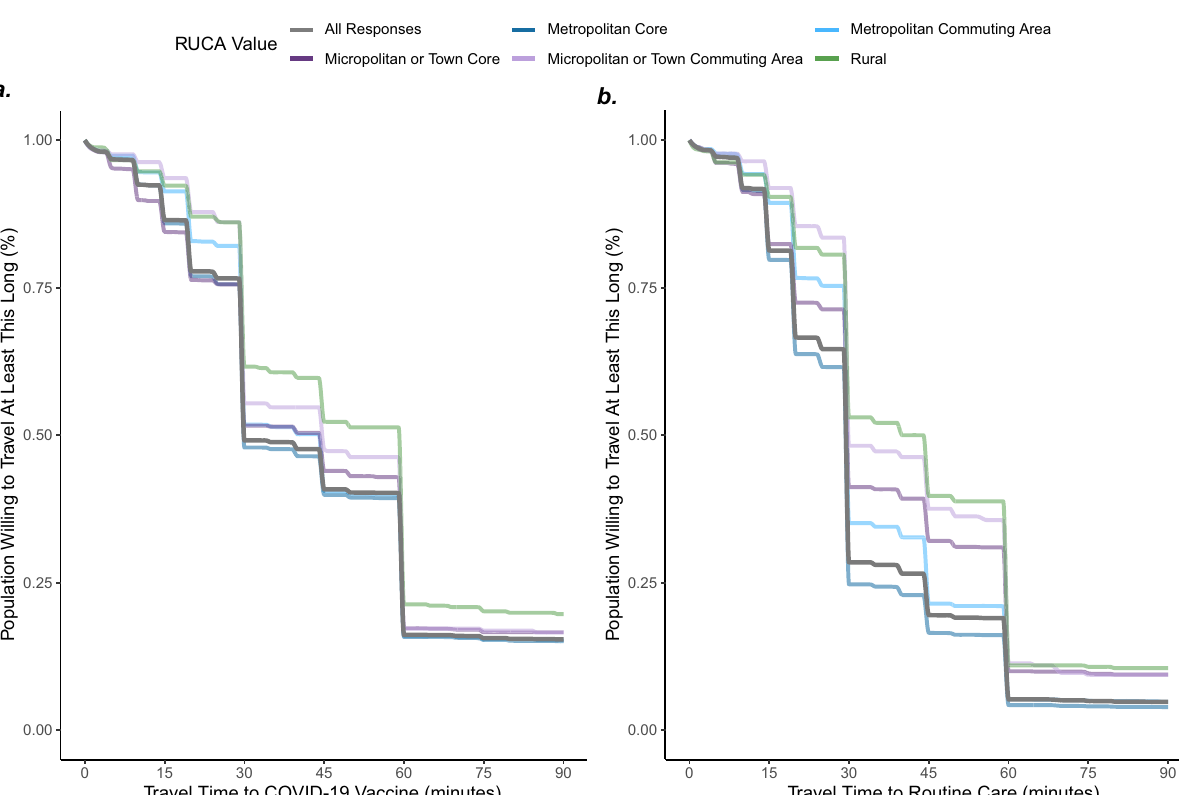
Fig. 1 Time willing to travel to COVID-19 vaccine compared to routine healthcare. Responses ( N = 23,288) from OutbreaksNearMe US national web survey on how long people were willing to travel to COVID-19 vaccine ( a ) compared to routine care ( b ). Lines are monotonic cubic splines fi t to 1 minus the empirical cumulative distribution of these response times. Responses were limited to individuals considering a vaccine, de fi ned as those who reported either “ yes ” or “ not sure ” when asked if they would get the vaccine. Results are broken down by U.S. Department of Agriculture Rural-Urban Commuting Area (RUCA) codes of the respondent ’ s self-reported zip code. Overall distribution of travel time to COVID-19 vaccine ( a gray ) was used as the travel-time decay function in E2SFCA